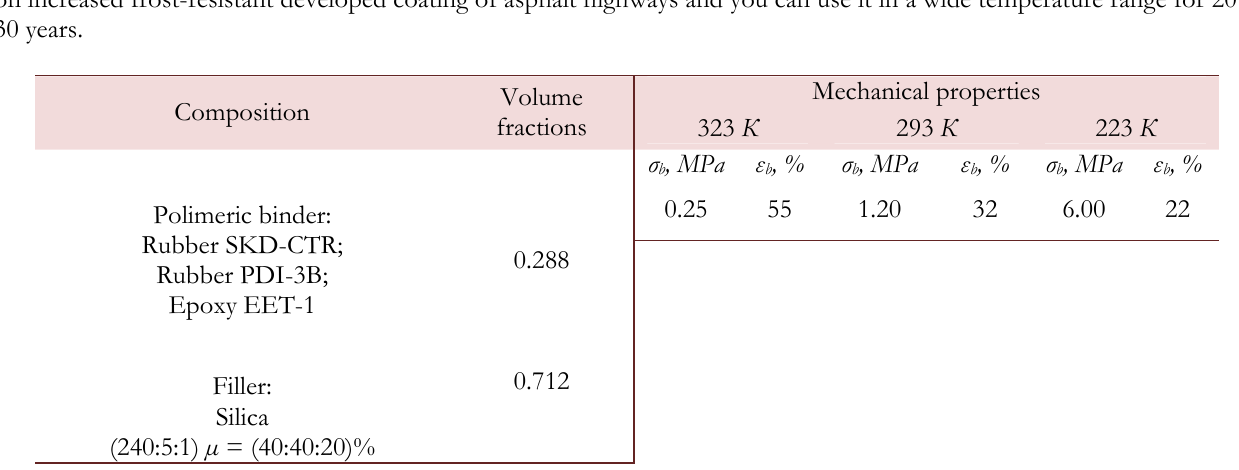
Table 2: Mechanical characteristics of